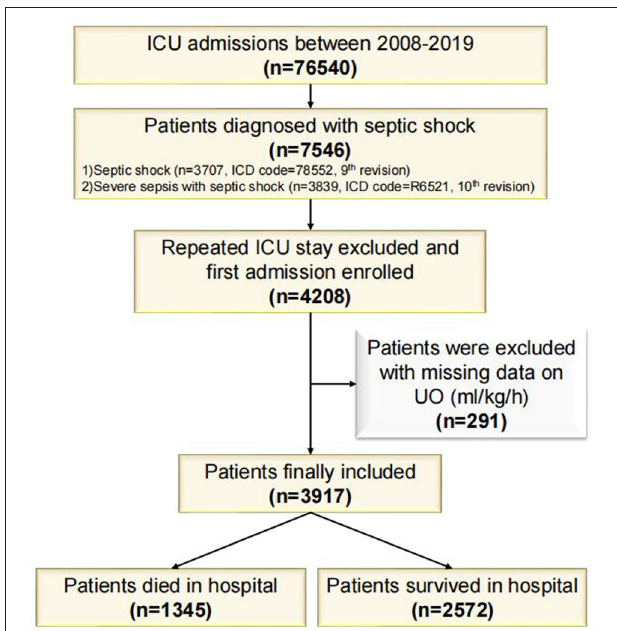
FIGURE 1 | Flowchart of study cohort. ICU, Intensive Care Unit; ICD, International Classification of Disease; UO, Urine Output.